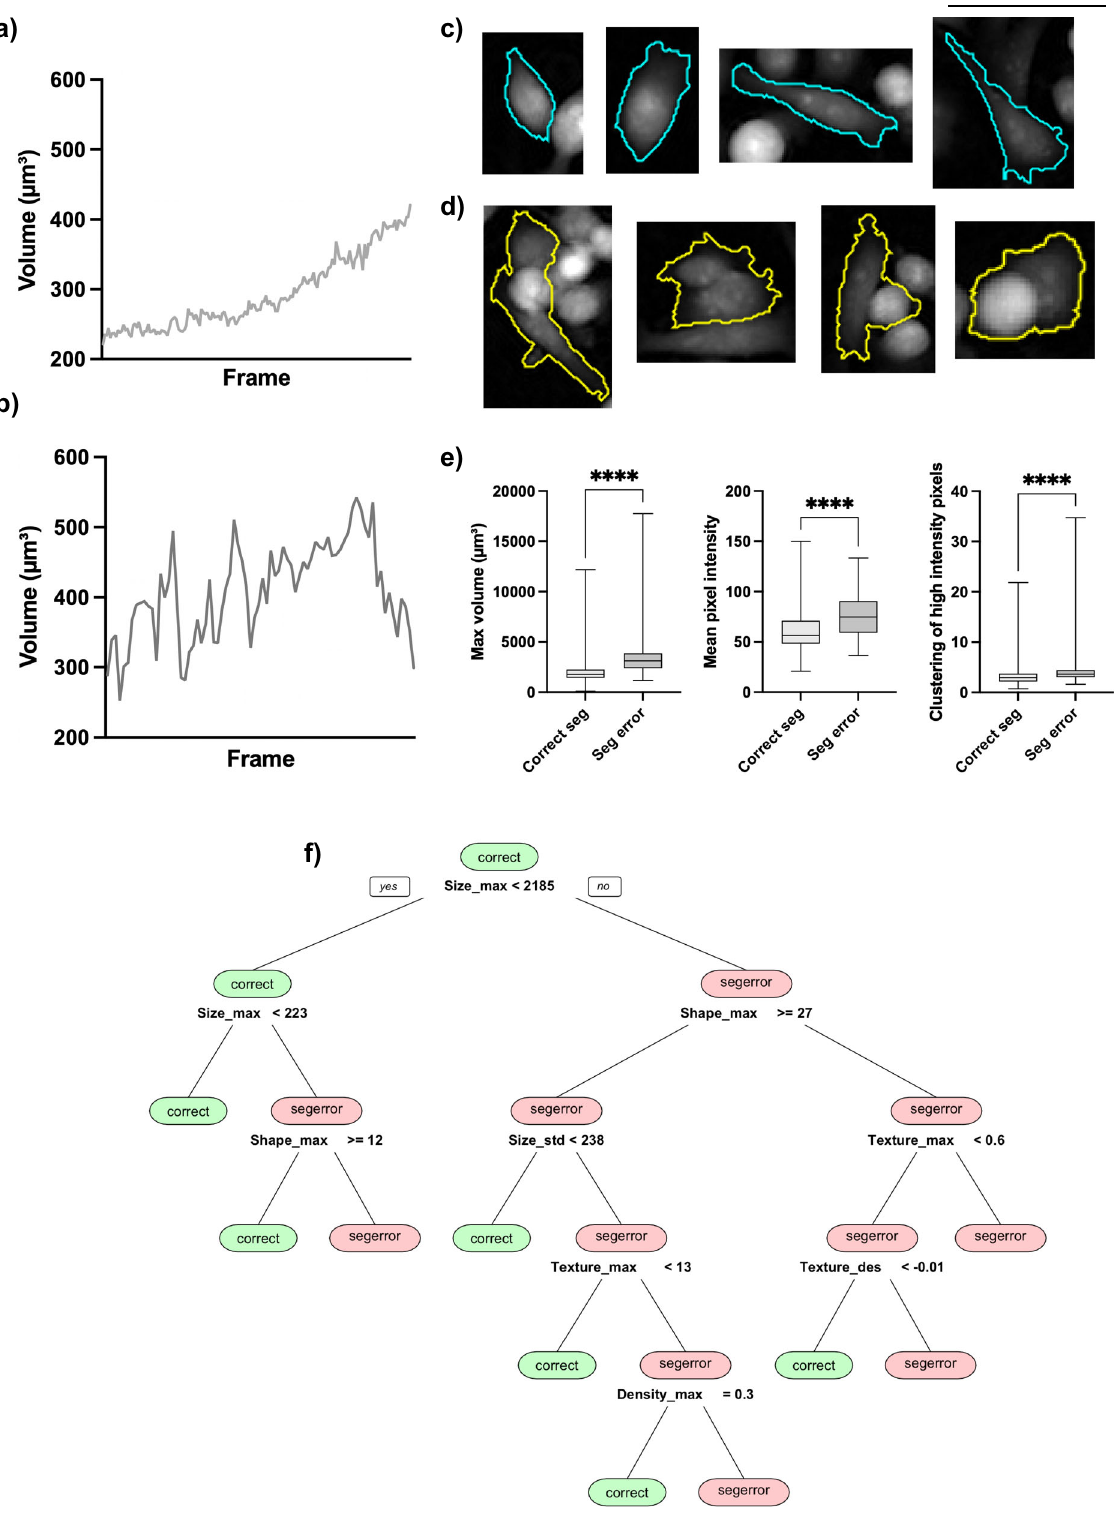
Fig. 2 | Characterisation of segmentation errors. a Volume time series for a correctly segmented cell and b a cell experiencing segmentation errors, demon- stratinggreater fl uctuationinvolumewhenacellexperiencessegmentationerrors. Examples of test set cells classi fi ed as c correct segmentation and d segmentation error. Note that the scale bar applies to all cell images in c , d . e Box and whisker plots of features that are signi fi cant for identifying segmentation errors in the 231Docetaxel training set (****: p <0.0001). The median value is shown by the line